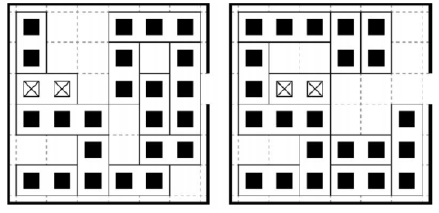
Figure 4. Rush hour